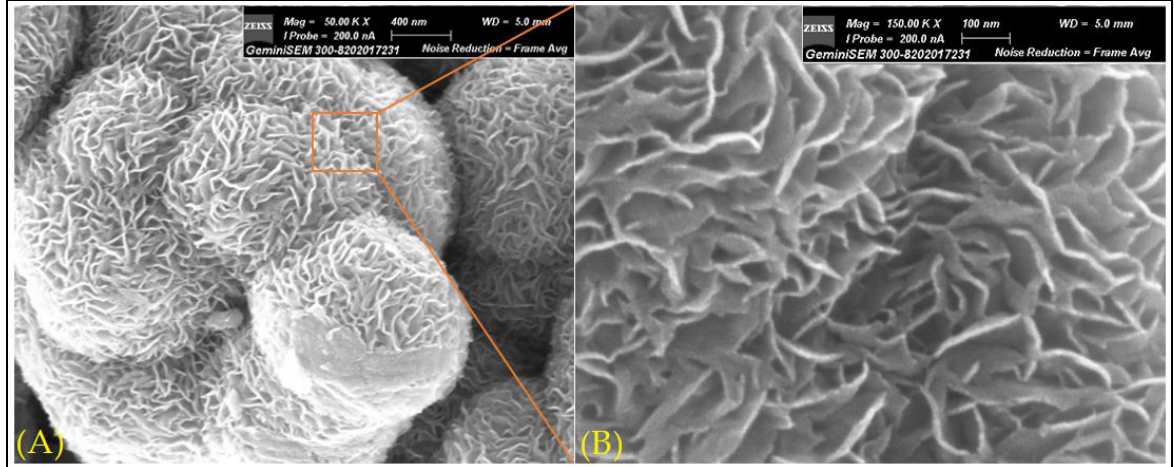
Figure 7. FESEM image for g-C 3 N 4 at magnifications of 400 nm ( A ) and 100 ( B ). Figure 8 shows that MoS 2 and g-C 3 N 4 in the developed composite are bundled to- gether, showing that the components of composite were mixed successfully and may pro- vide the lubrication property of the coating. Figure 8. FESEM images 9 wt% g-C 3 N 4 /MoS 2 at magnifications of 400 nm ( A ) and 100 ( B ). It can be seen from Figure 9 that on increasing the weight percentage of graphitic carbon nitride in the composite, MoS 2 predominates.